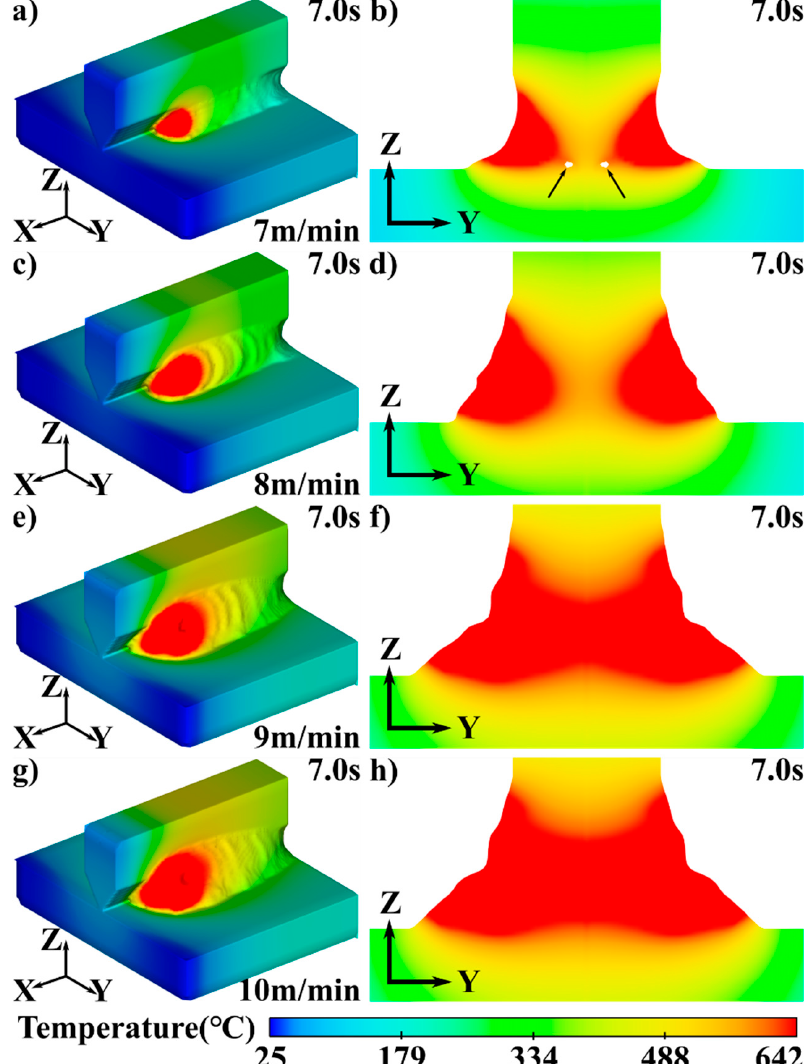
Figure 9. Temperature distributions on the model surface: wire feed speeds of ( a ) 7 m/min, ( c ) 8 m/min, ( e ) 9 m/min, ( g ) 10 m/min; temperature distributions on the cross sections: wire feed speeds of ( b ) 7 m/min, ( d ) 8 m/min, ( f ) 9 m/min, and ( h ) 10 m/min.